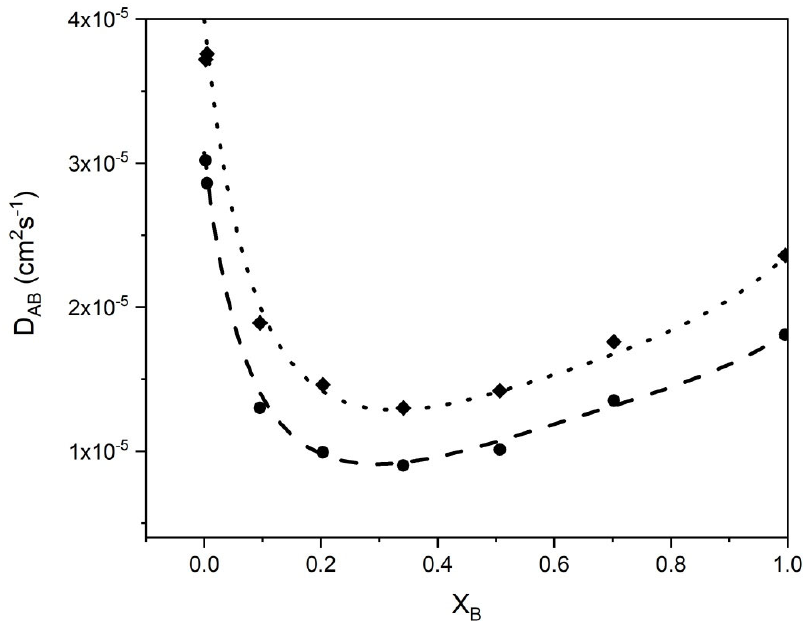
Figure 9. Diffusion coefficients D AB in a binary system of benzene (A) ‐ ethanol (B) at 25 °C with experimental ( ● ) [35] and calculated ( ‐‐‐ ) values with Equation (28), and at 40 °C with experimental ( ♦ ) [35] and calculated (…) values with Equation (28).